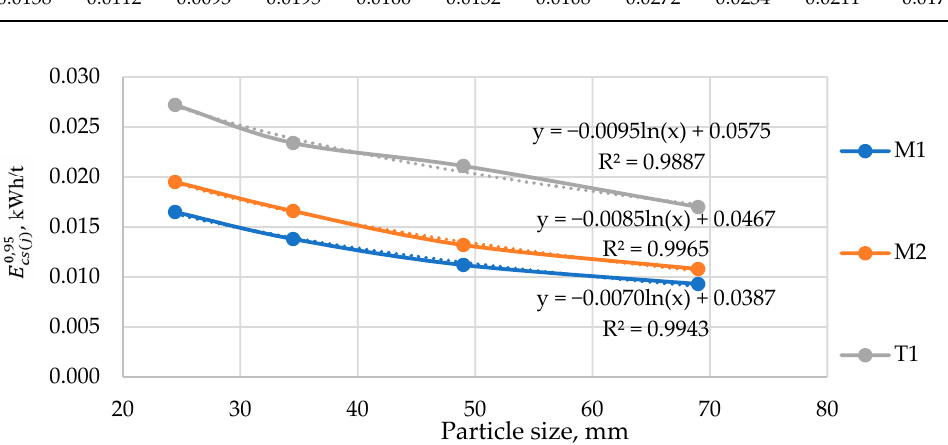
Figure 15. Nominal specific particle’s breakage energy of various sizes of the studied ore types.